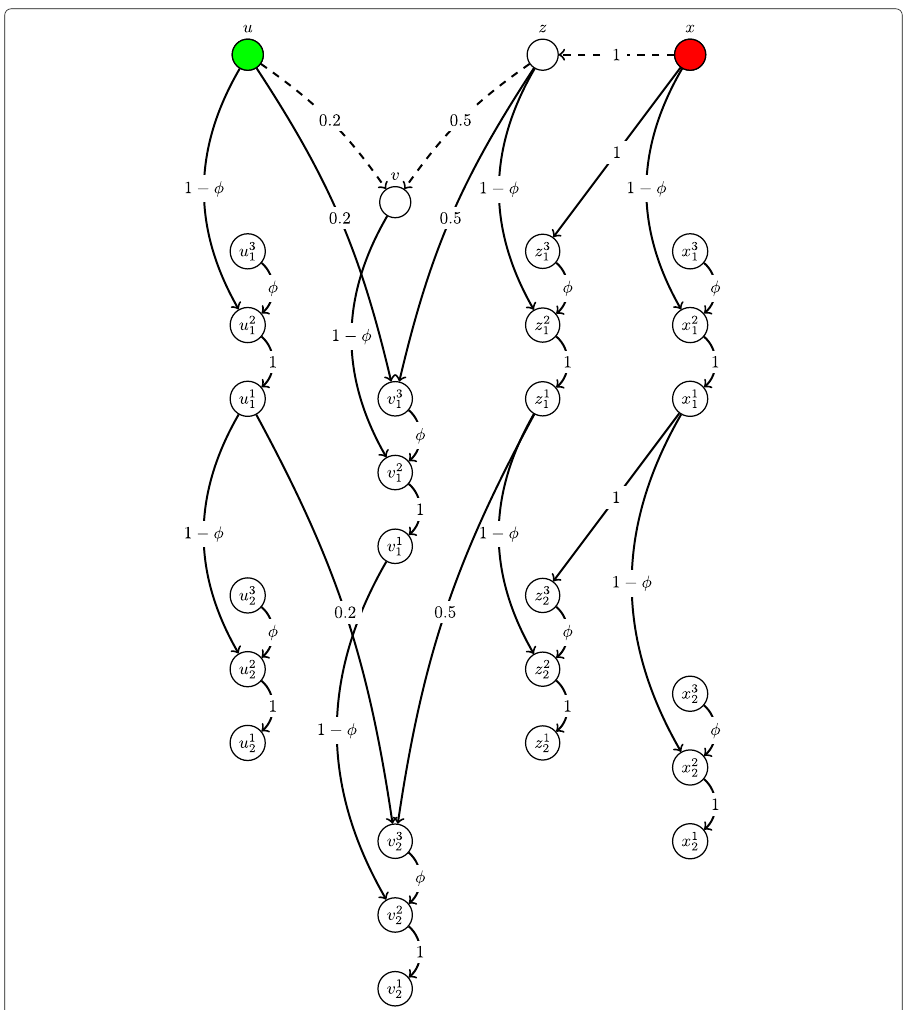
Fig. 18 Serialization of the diffusion subgraph involving nodes u , v , z , x , under spC - F 2 DLT , with time horizon set to 2. Symbol φ denotes a value chosen at random in